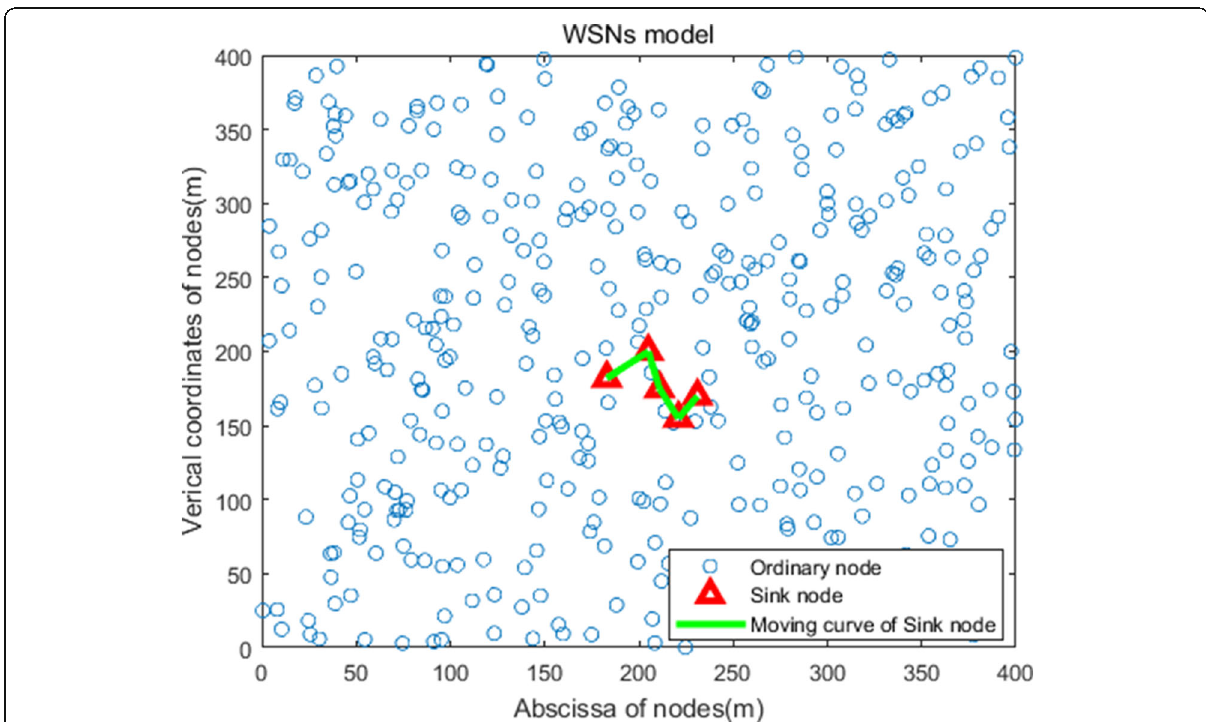
Fig. 1 Sensor network model. The real wireless sensor network is abstracted as ordinary nodesand sink